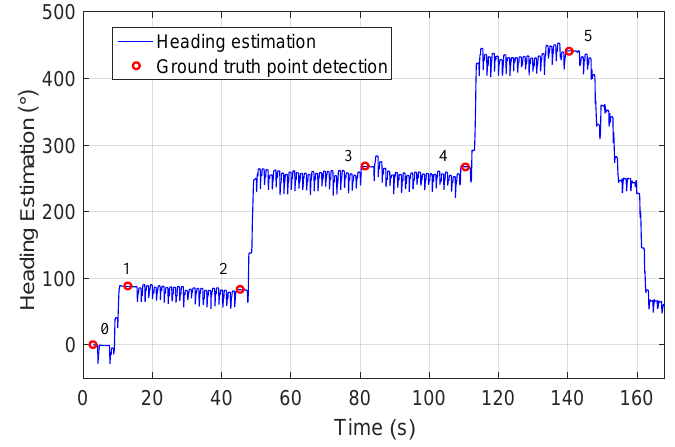
Figure 7. The blue curve represents the heading estimation for one volunteer corresponding to the second floor and the stairs. The ground truth points are highlighted with red circles and labeled, corresponding to Figure